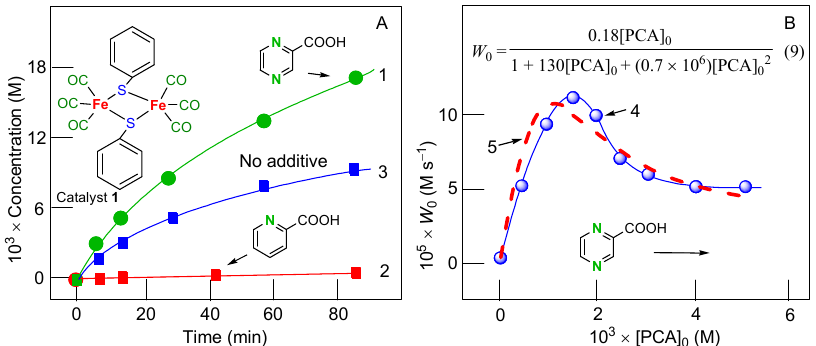
Figure 1. Graph ( A ). Accumulation of oxygenates (cyclohexyl hydroperoxide + cyclohexanol + cyclohexanone) with time in the cyclohexane oxidation with H 2 O 2 catalyzed by compound 1 in acetonitrile in the presence of two different co-catalysts: PCA (3.0 ˆ 10 ´ 3 M; curve 1) and PIC (3.0 ˆ 10 ´ 3 M; curve 2) or in the absence of additives (curve 3). Conditions: [ 1 ] 0 = 2.0 ˆ 10 ´ 4 M, [pyridine] 0 = 0.2 M, [H 2 O 2 ] 0 = 0.64 M, [cyclohexane] 0 = 0.37 M, 50 ˝ C. Graph ( B ). Curve 4: dependence of the initial rate W 0 of oxygenate accumulation in the cyclohexane oxidation with H 2 O 2 catalyzed by 1 in acetonitrile on the initial concentrations of PCA. Curve 5: simulated dependence of the initial rate W 0 on [PCA] 0 corresponding to Equation (6). Conditions: [ 1 ] 0 = 2.0 ˆ 10 ´ 4 M, [pyridine] 0 = 0.1 M, [H 2 O 2 ] 0 = 0.64 M, [cyclohexane] 0 = 0.37 M, [H 2 O] total = 1.21 M, 50 ˝ C. Adapted from Ref.